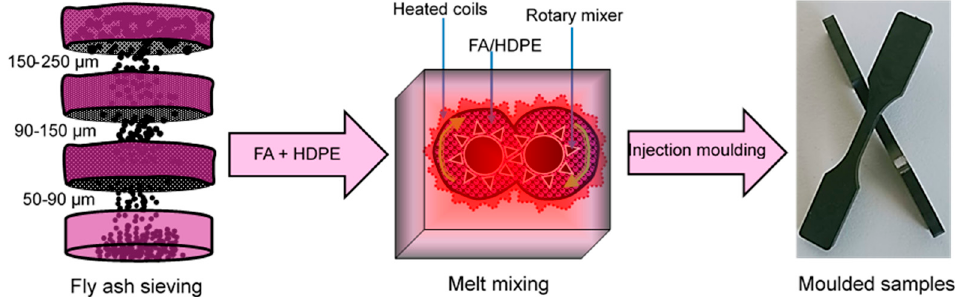
Figure 1. Fabrication method of the FA/HDPE composites with different sized fly ash particles.